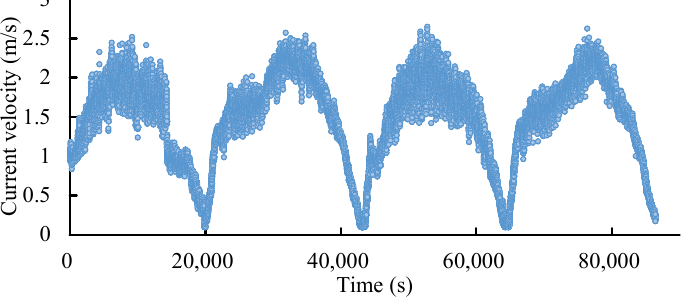
Figure 6. Tidal current velocity over an entire day.